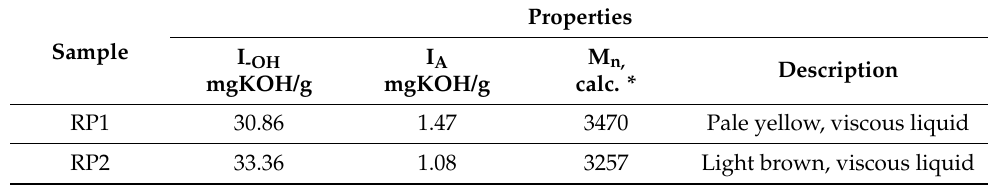
Table 4. Assessment of I OH and I A for the polyester-polyols that resulted from the degradation of PET, through titration methods.